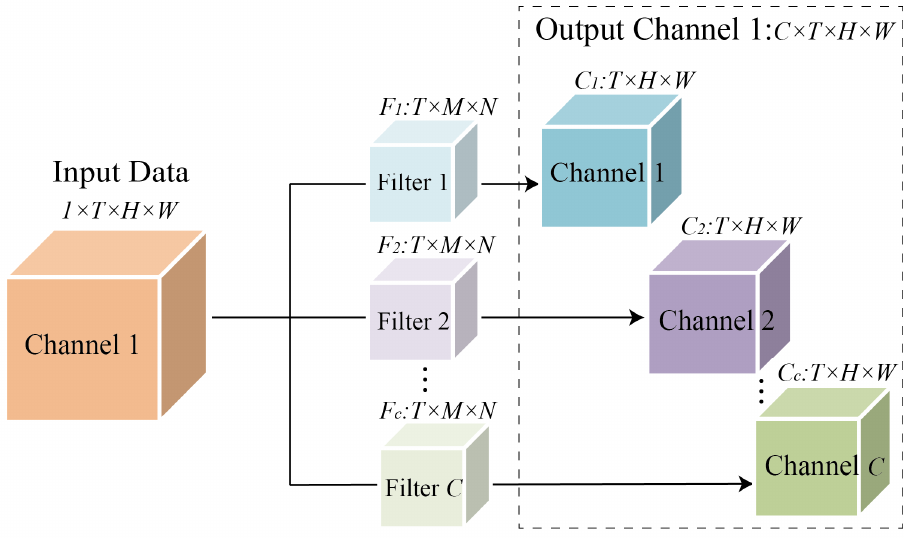
Figure 4. The structure of 3D CNN.